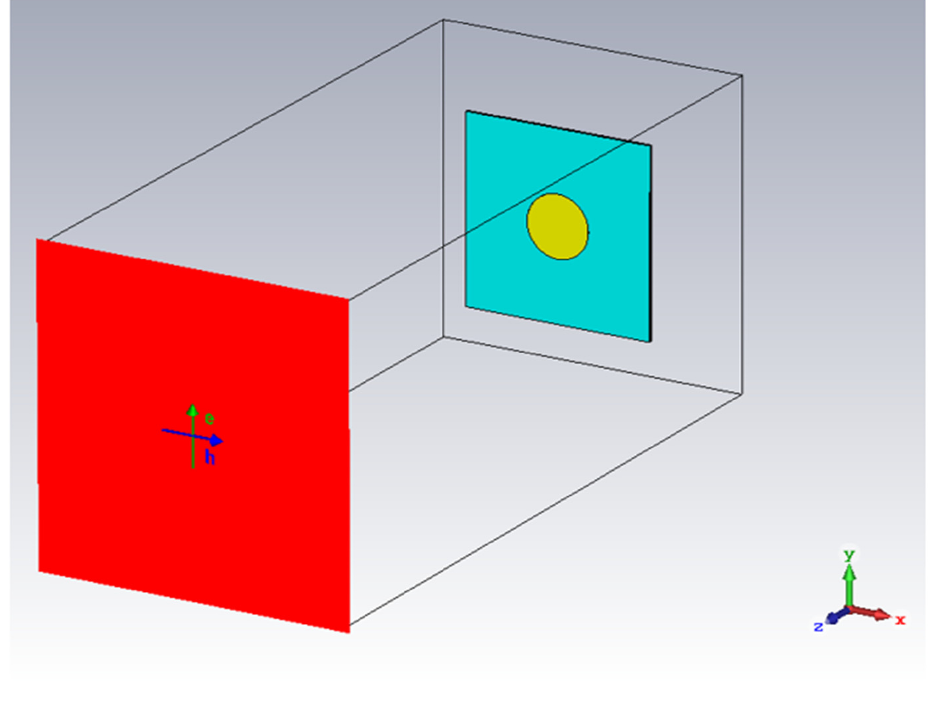
Figure 6. Simulation set up in CST Studio Suite.